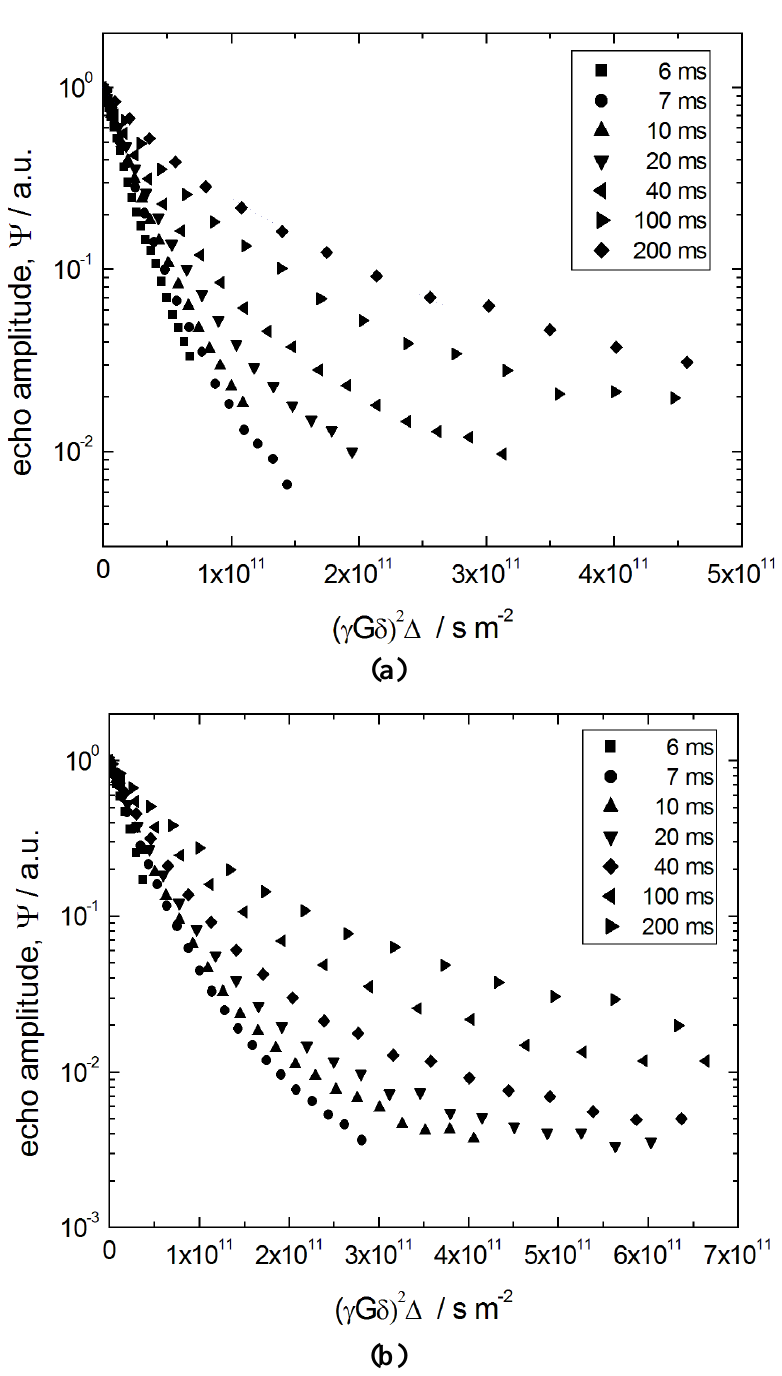
Figure 9. Spin-echo diffusion attenuation curves at different diffusion times of Δ = 6, 7, 10, 20, 40, 100 and 200 ms for ( a ) n-heptane in the initial silica gel (S0) obtained; and ( b ) the completely transformed material